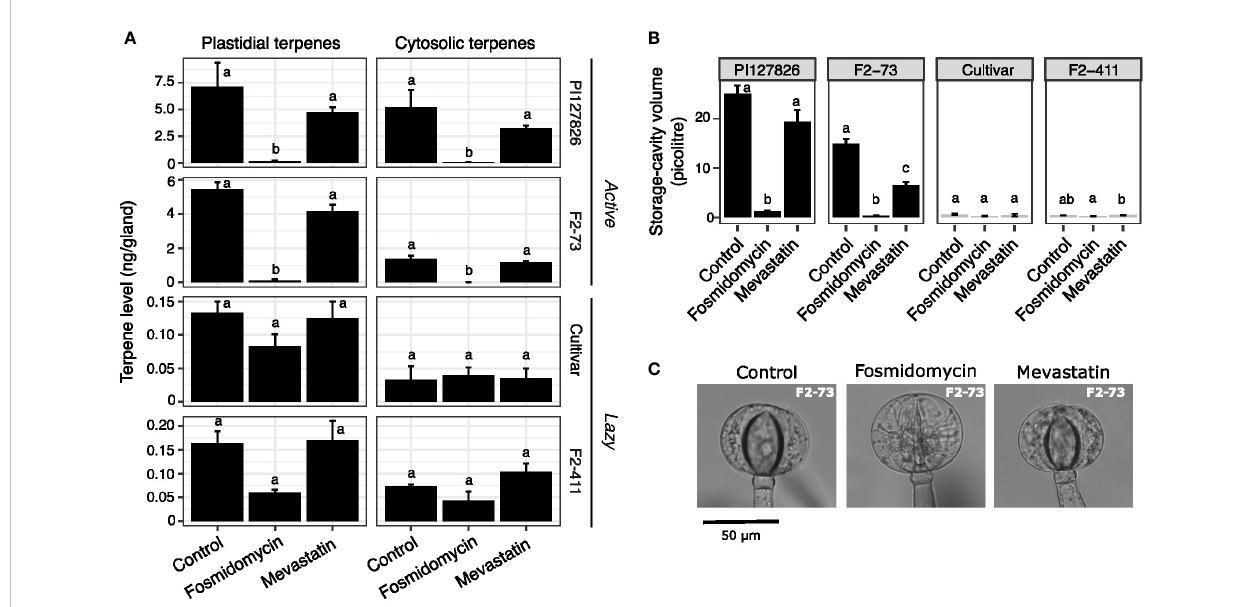
FIGURE 5 The effect of MEP/MVA pathway inhibition on plastidial-and cytosolically produced terpenes and the storage cavities. Cuttings (n = 3) of active (PI127826 and F2-73) and lazy (cultivar and F2-411) genotypes were grown for 14 days in hydroponic solution supplied with 10 m M fosmidomycin or 10 m M mevastatin. (A) Terpene levels in the type-VI trichome glands after 14 days of treatment. Terpene levels are summed according to the sub- cellular localisation (i.e. plastidial of cytosolic) of the corresponding terpene synthase (Zhou et al., 2020). The summed terpene quantities were Log 2 - transformed prior to ANOVA. Letters indicate signi fi cant groups (p < 0.05) after a Tukey HSD post-hoc test. (B) Volume of the storage cavity after 14 days of treatment. Letters indicate signi fi cant groups (p < 0.05) according to Tukey HSD post-hoc test after ANOVA of Log 2 -transformed cavity volumes (C) Representative microscope images type-VI trichome glands on the leaves of F2-73 after 14 days of treatment.